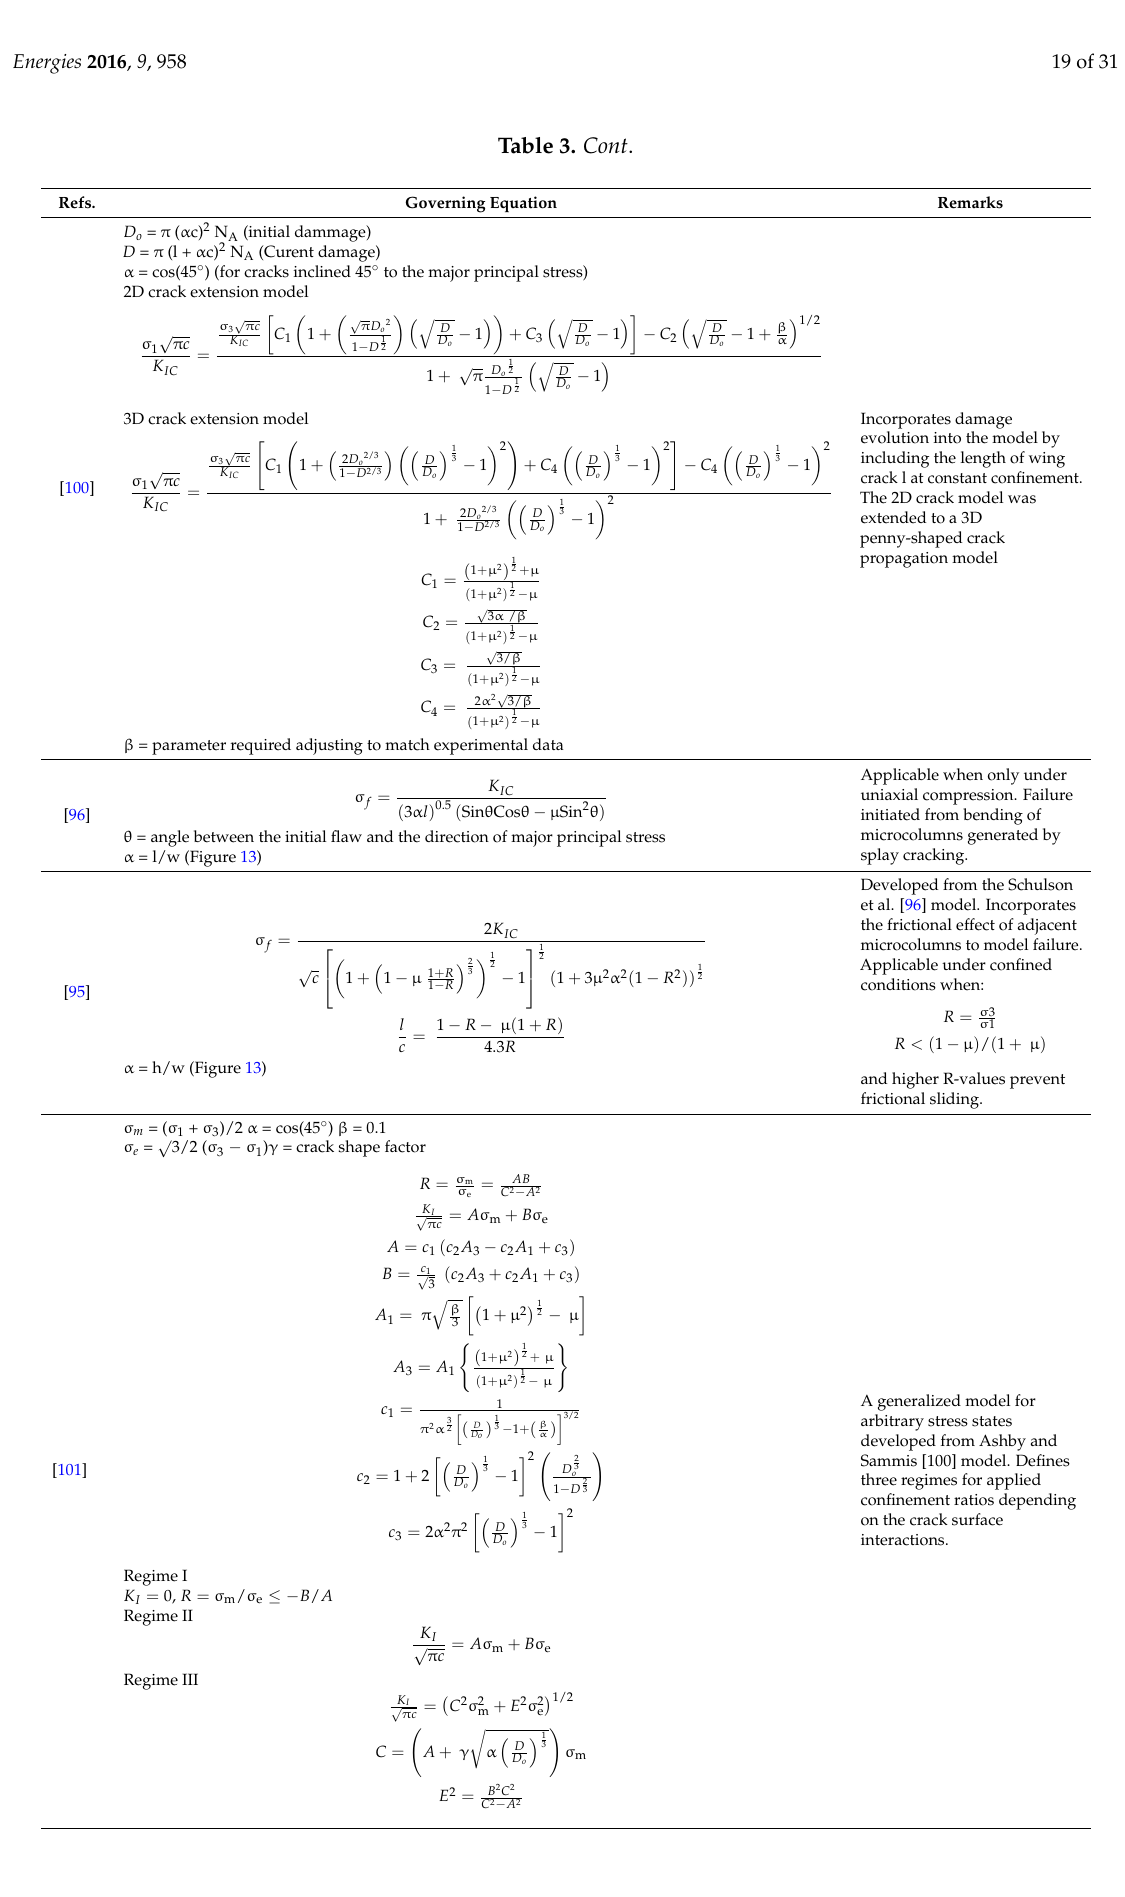
Governing Equation